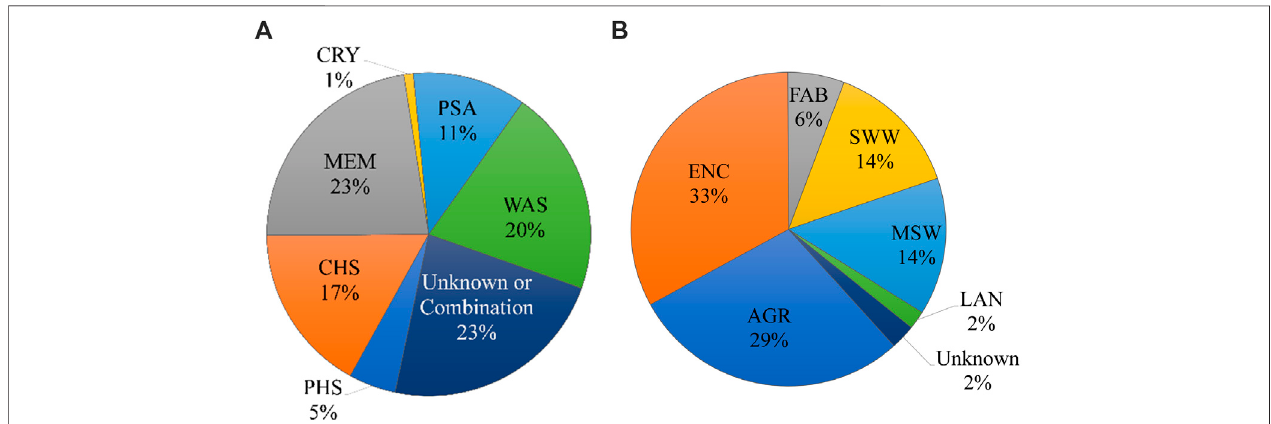
FIGURE1| Shareofcapturetechnologies (A) andanaerobicdigestionsubstrates (B) utilizedinbiomethaneplantsinstalledinEuropeattheendof2019(European Biogas Association, 2020).